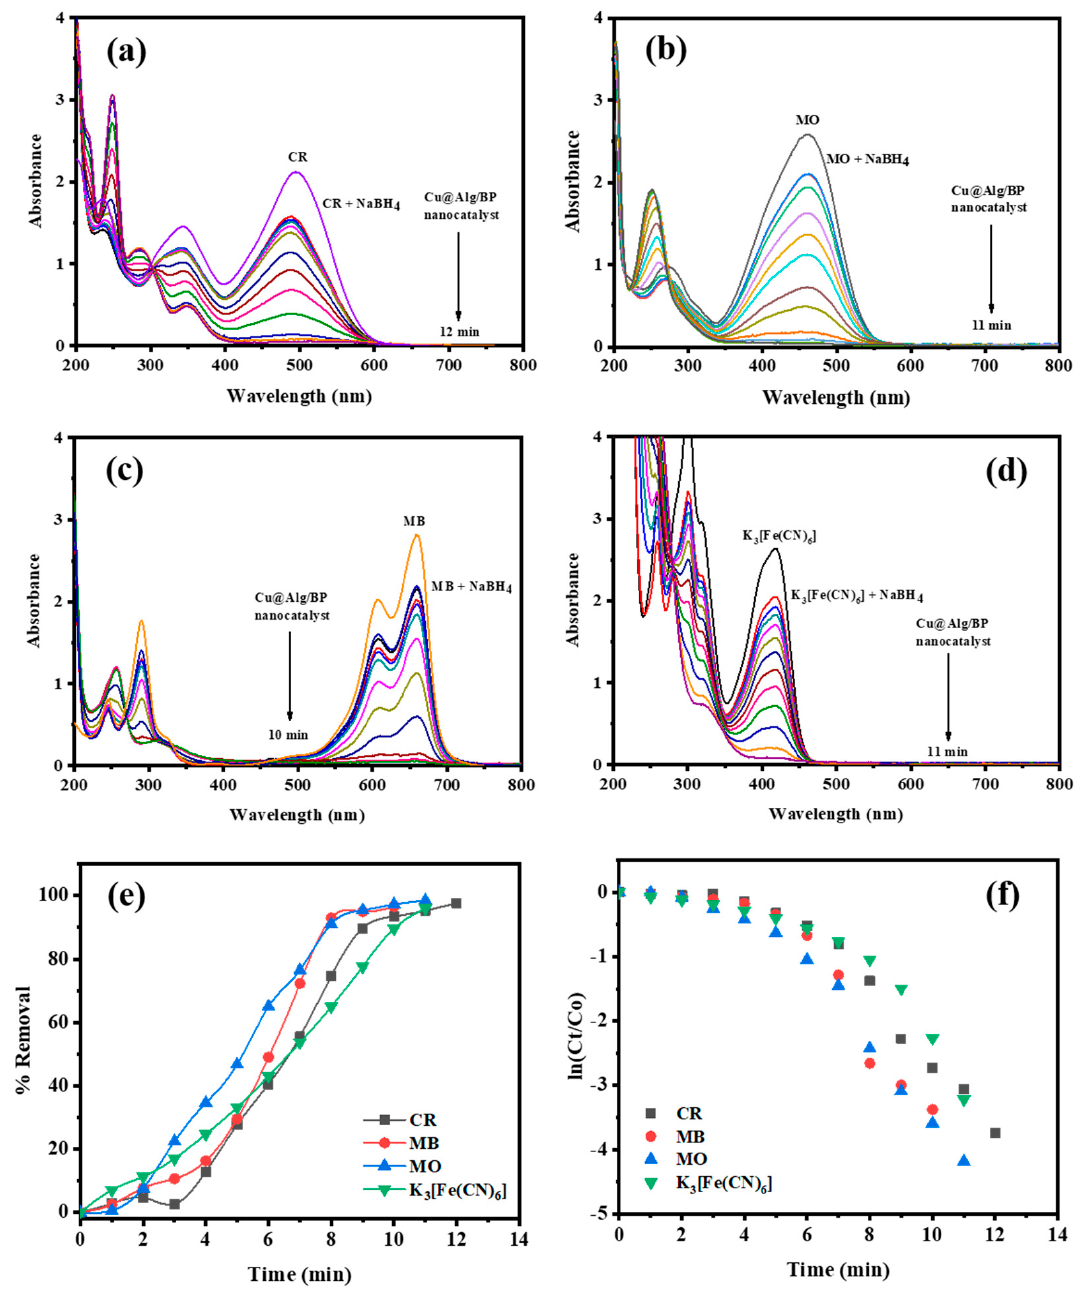
Figure 4. Time dependent UV–vis spectra for the reduction of ( a ) CR (0.065 mM); ( b ) MB (0.065 mM); ( c ) MO (0.108 mM); ( d ) K 3 [Fe(CN) 6 ] (2.0 mM) by NaBH 4 using 2 beads of Cu@Alg/BP. ( e ) Removal % and ( f ) kinetics of pollutants reduction using